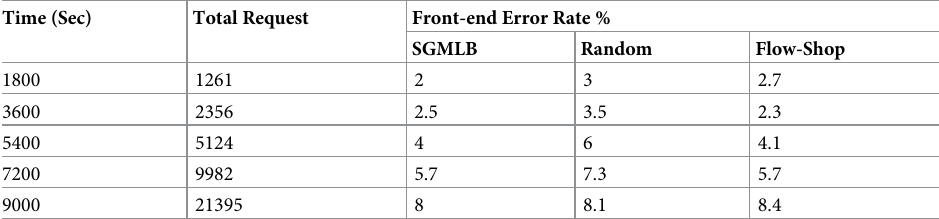
Table 5. Front-end error rate.